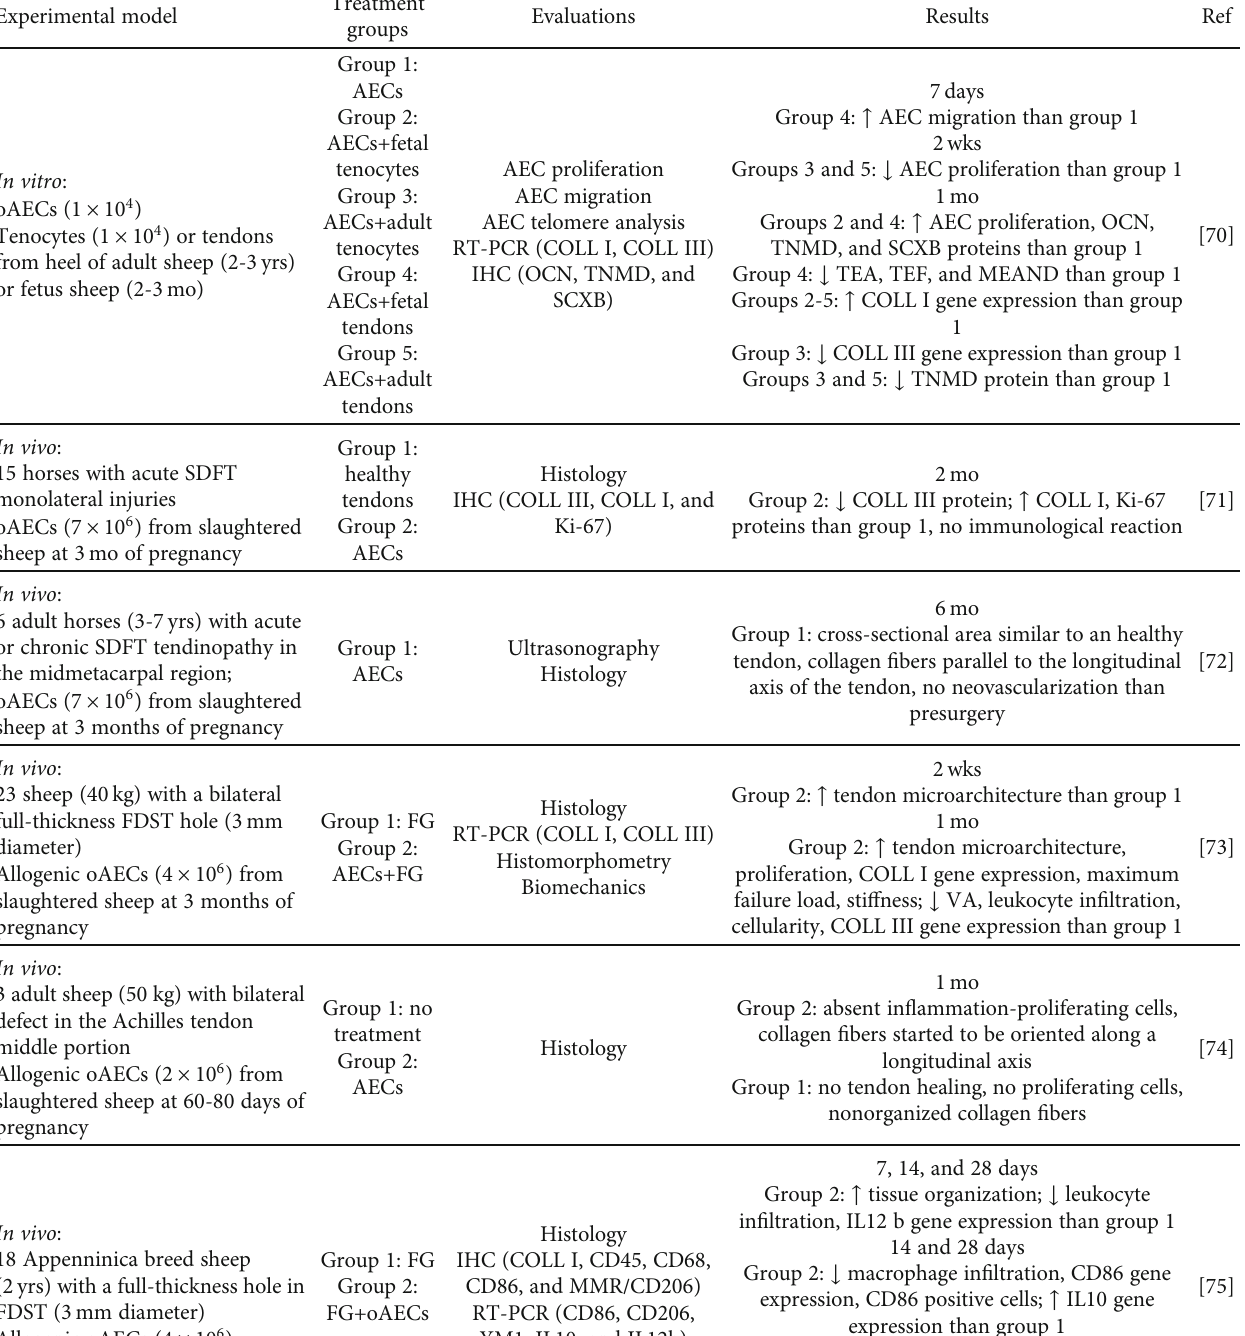
Table 6: In vitro , in vivo , and clinical studies on AECs in tendon